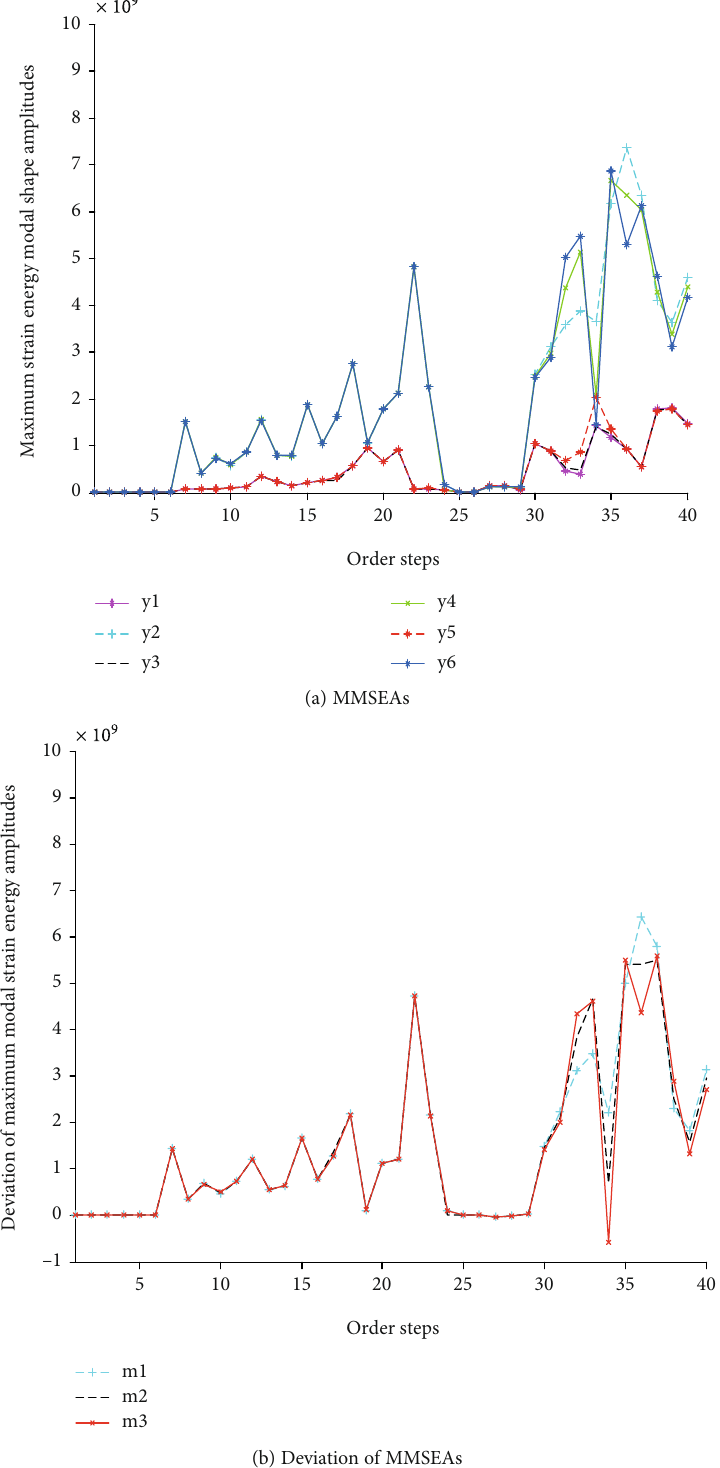
(b) Deviation of MMSEAs Figure 9: Maximum modal strain energy amplitudes analysis in di ff erent temperatures. (a) MMSEAs: tuned bladed disk: y1: t = 650 ° C ; y3: t = 850 ° C ; y5: t = 1050 ° C . Mistuned bladed disk: y2: t = 650 ° C ; y4: t = 850 ° C ; y6: t = 1050 ° C . (b) Deviations of MMSEAs: mistuned bladed disk relative to tuned bladed disk: m1: t = 650 ° C ; m2: t = 850 ° C ; m3: t = 1050 ° C